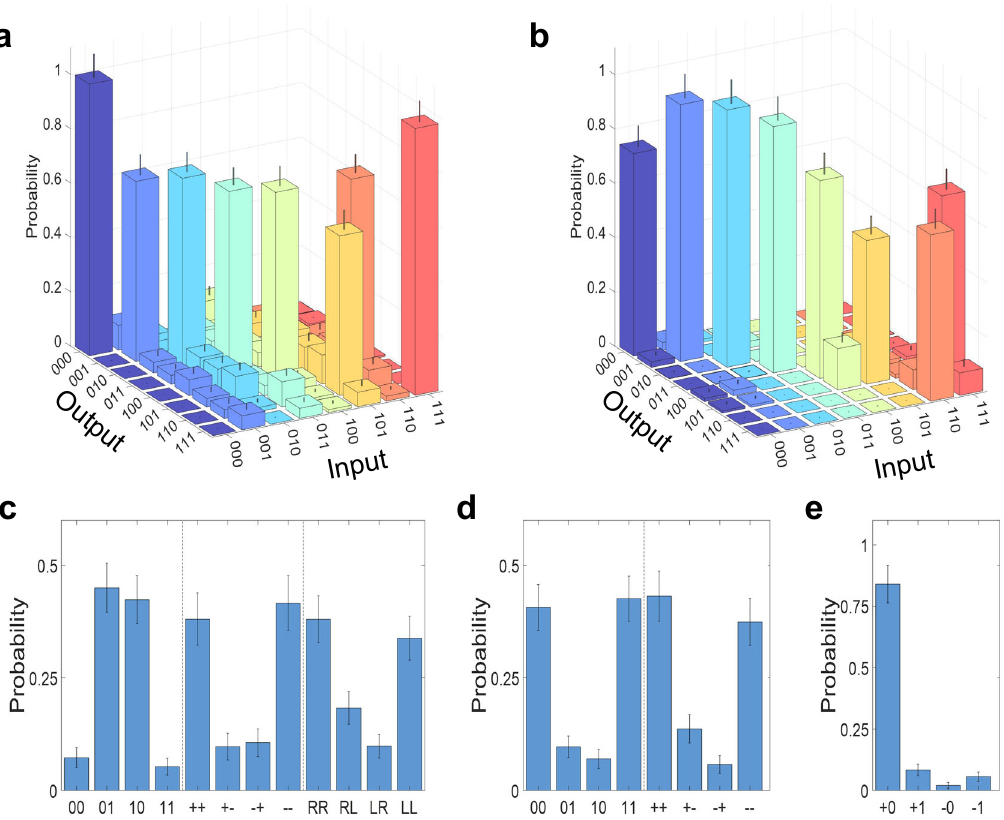
Fig. 3 Experimental results for three-qubit logic gates. a and b show truth tables of the constructed Fredkin and Toffoli logic gates, respectively. The x and y axes are eight calculation basis for input and output states. c Measured results for determining the fi delity of target qubits for the input state þ ; 0 ; 1 j i of the Fredkin gate. R = L